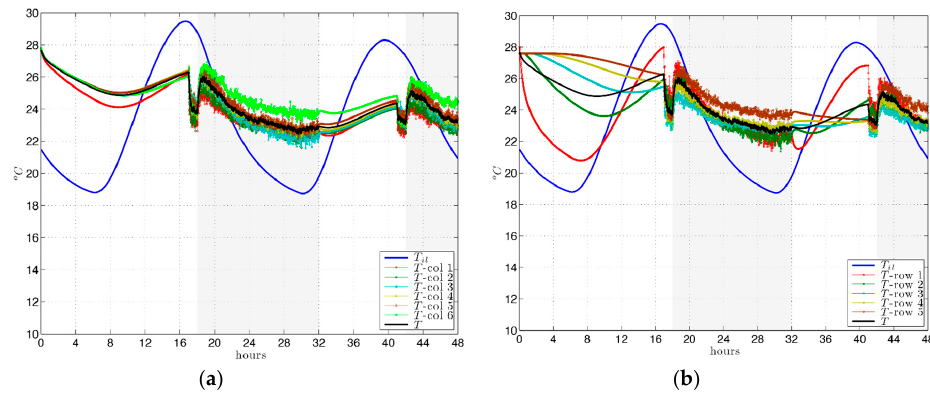
Figure 15. Case 2: Efficient energy proposal. Summer with free cooling. Internal layer temperature T il and averaged room temperature T together with calculated indoor temperatures at the probe points given in Figure 4. ( a ) by columns; ( b ) by rows.